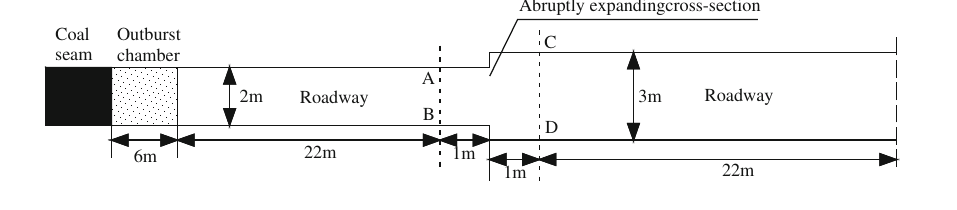
Fig. 12 Geometry of abruptly expanding roadway